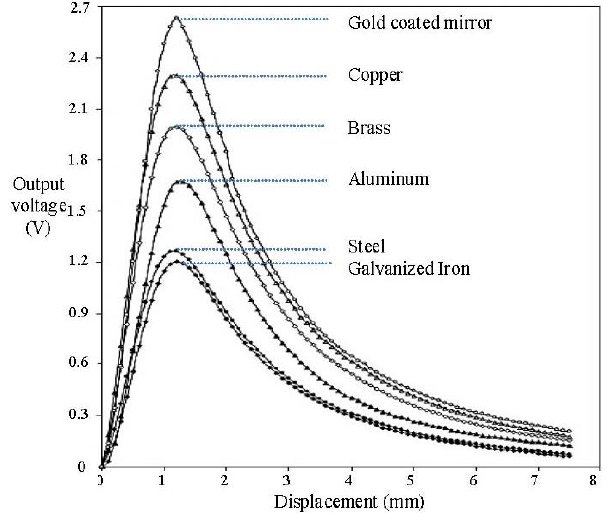
Figure 3. Response of fibre optic reflectivity of different reflector materials